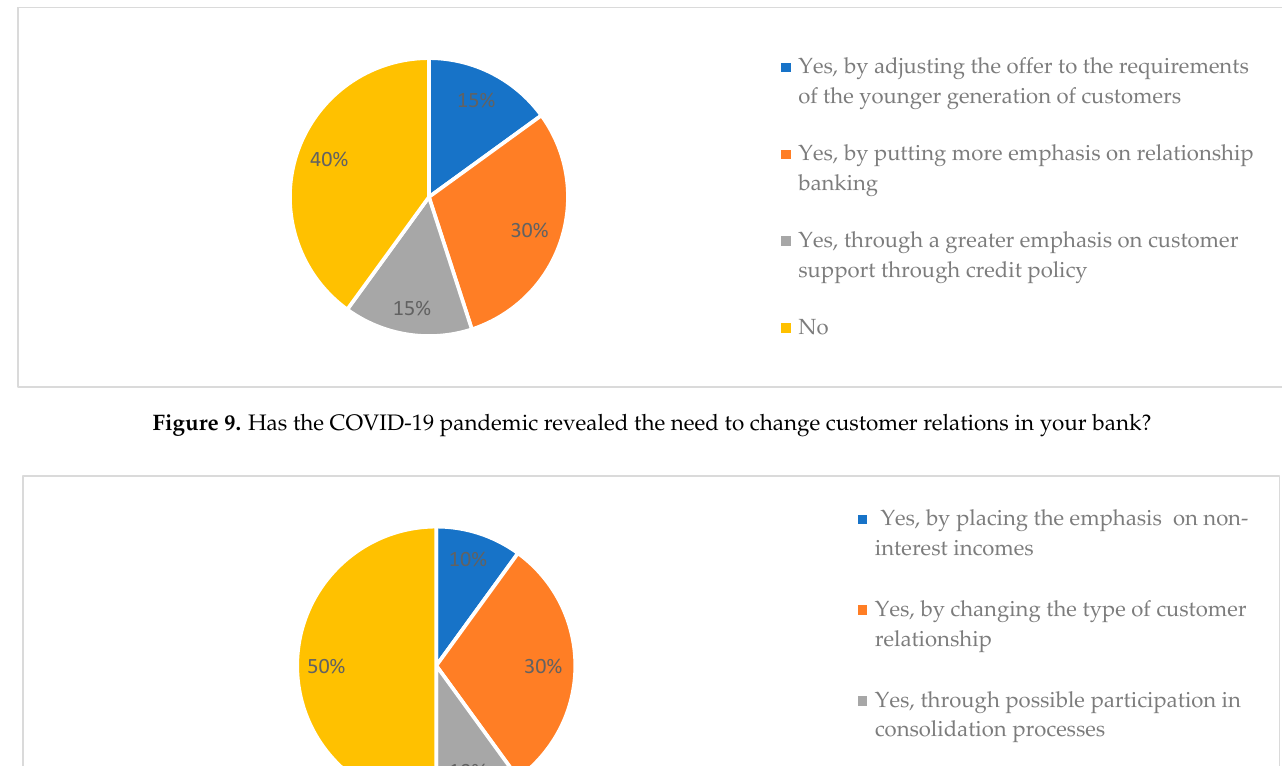
Figure 8. Has the COVID-19 pandemic revealed the need to change technological solutions in your bank?